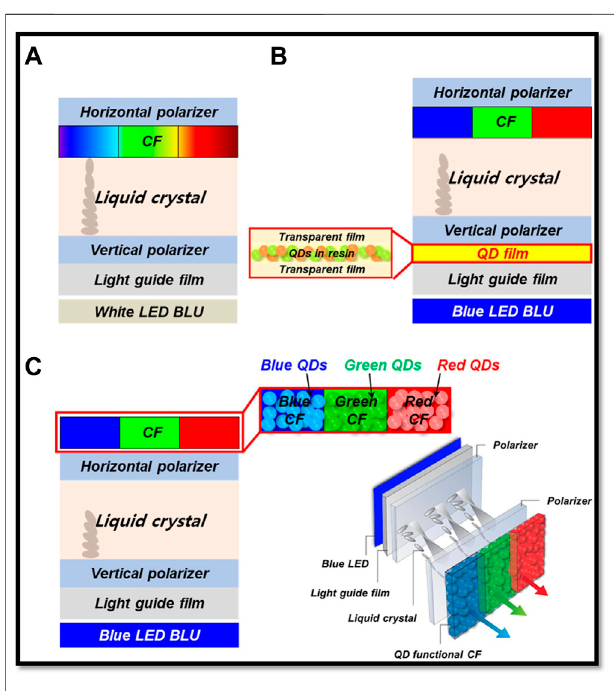
FIGURE 7 | Perovskite QD backlight device fabrications and LCD performance. (A) LCD structure with color fi lter (CF), (B) PQD-enhanced thin fi lms incorporated between light-guided fi lms and vertical polarizer, and (C) white light generation due to color conversion phenomenon of PQD EFs (Ko et al.,